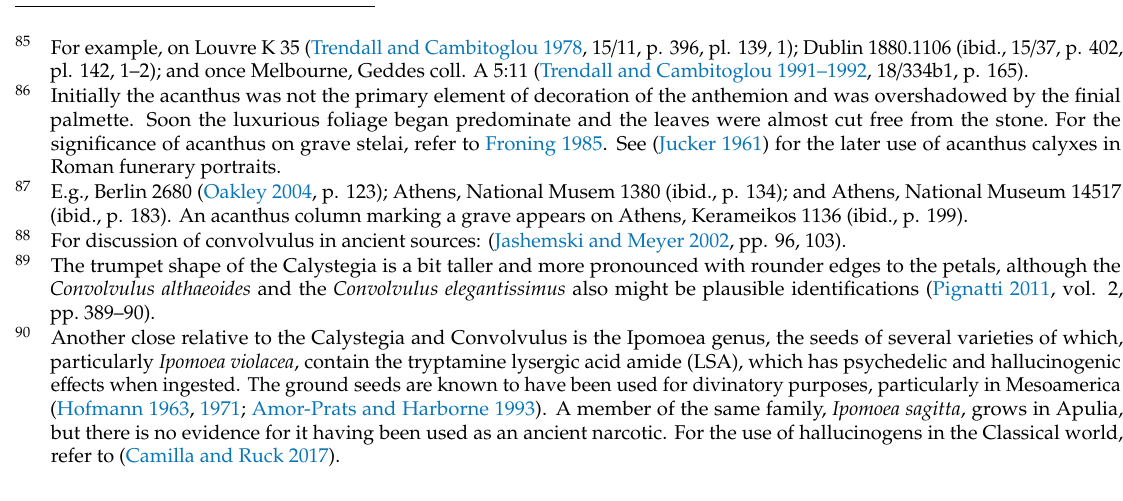
Figure 25. ( a ) Melbourne, National Gallery of Victoria D88–1969 Apulian volute-krater, Ganymede Painter, ca. 330–320 B.C. Female head in three-quarter view to left wearing saccos emerging from a flower surrounded by floral tendrils (detail of neck on obverse side). Author’s photo. ( b , c ) Large Bindweed ( Calystegia silvatica ). Photographs courtesy of Wikimedia Commons.